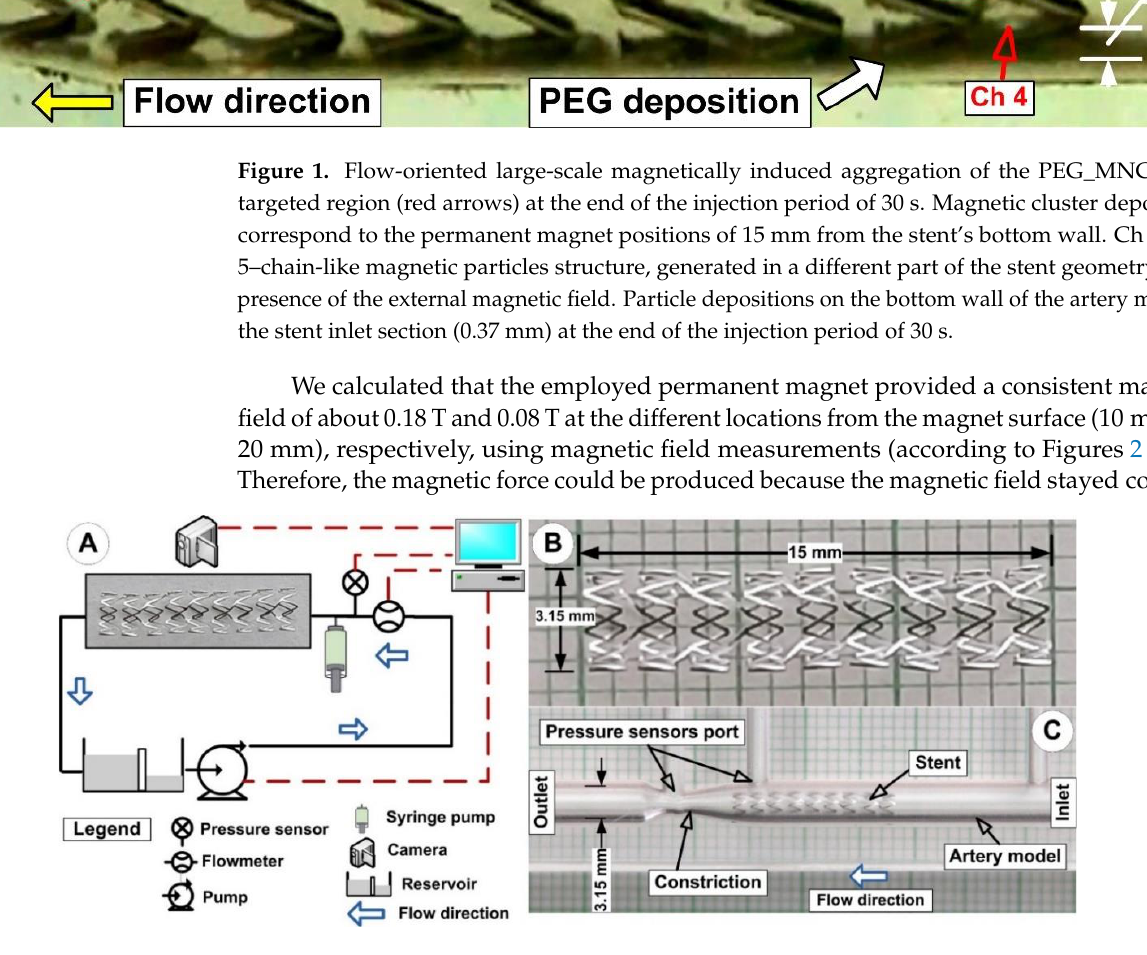
Figure 2. Implanted stent, particle targeting experimental setup. ( A ) The flowmeter, pressure sensors, suspension injection mechanism with a syringe pump, test section with magnetic stent model, reservoir, centrifugal pump, camera, and PC were all shown in the block diagram of the main recirculating flow loop. A suspension is injected using a syringe pump before the stent model enters part. ( B ) A general perspective of the stent geometry used and the distinctive dimension of the expanded stent. ( C ) Aerial view of the model artery showing the position of the stent.